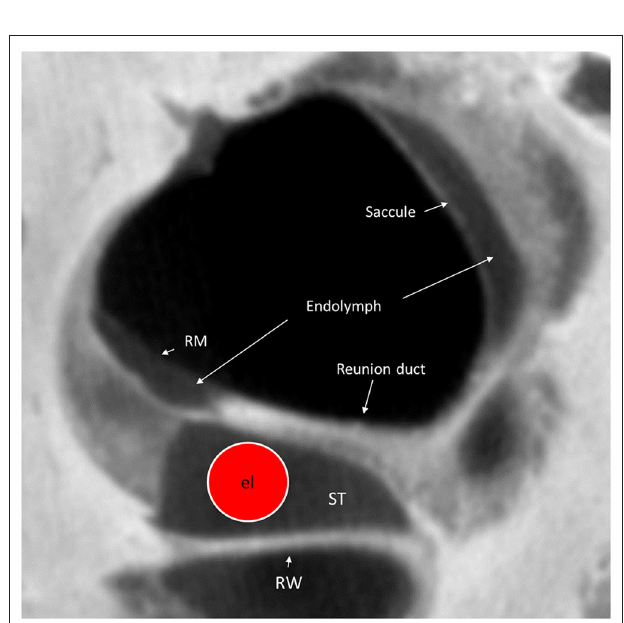
FIGURE 10 | Micro-CT cross-section of the cochlear base at the RW. A virtual CI electrode (el) is placed in the scala tympani. The RD can hardly be seen on the superior surface of the OSL. RM, Reissner’s membrane; ST, scala tympani; RW, Round